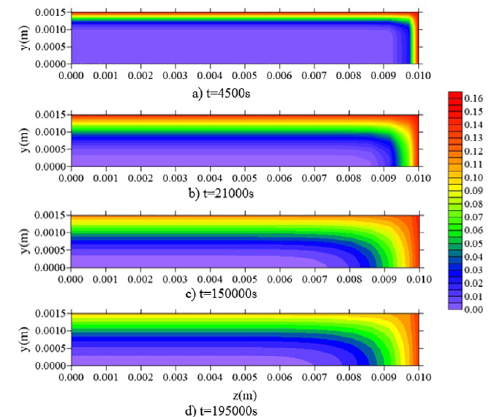
Figure 7. Distribution of the free solute concentration (C) in the x = R /2 plane for different water absorption times. x